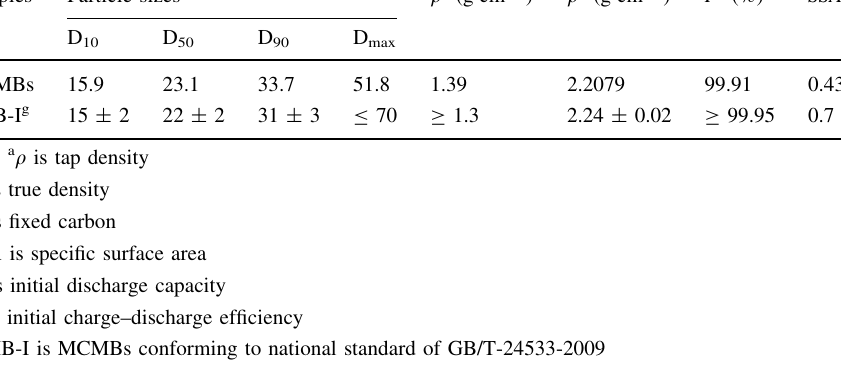
Table 8 The performance of graphitized MCMBs 10 as a negative electrode material Samples